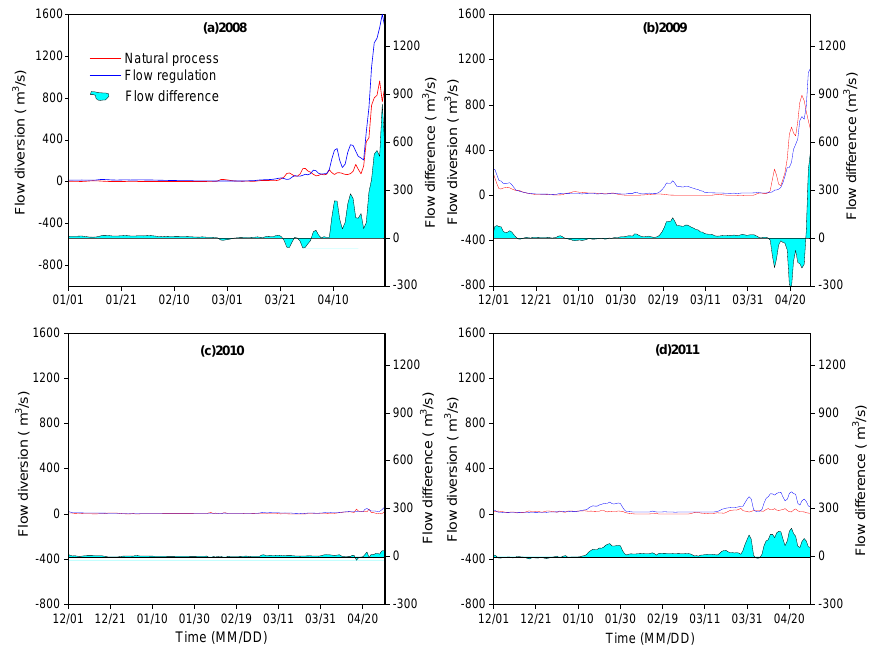
Figure 4. Flow diversions during the dry seasons with and without the TGR. Table 4. Monthly mean discharge and flow diversion ratio with and without the TGR during the dry seasons from 2008 to 2011, %.